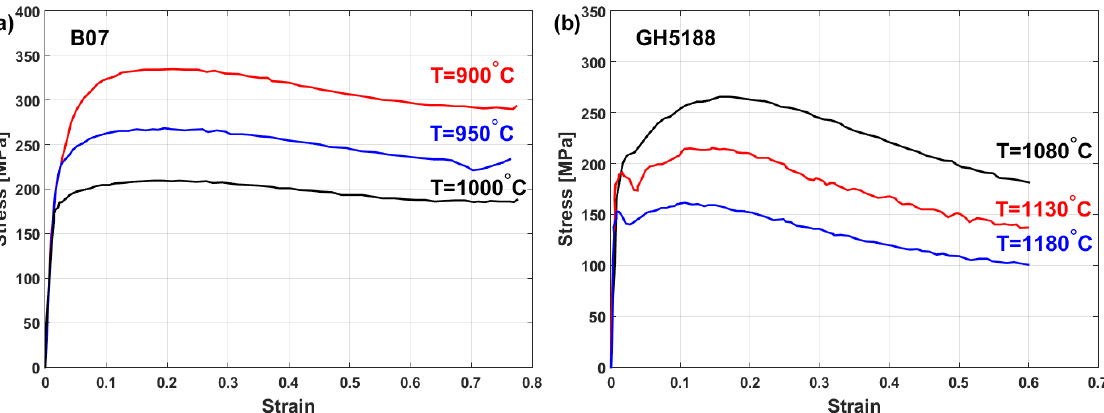
Figure 2. Flow stress curves during hot deformation at 0.1 s −1 for ( a ) B07 superalloy and ( b ) GH5188 superalloy.